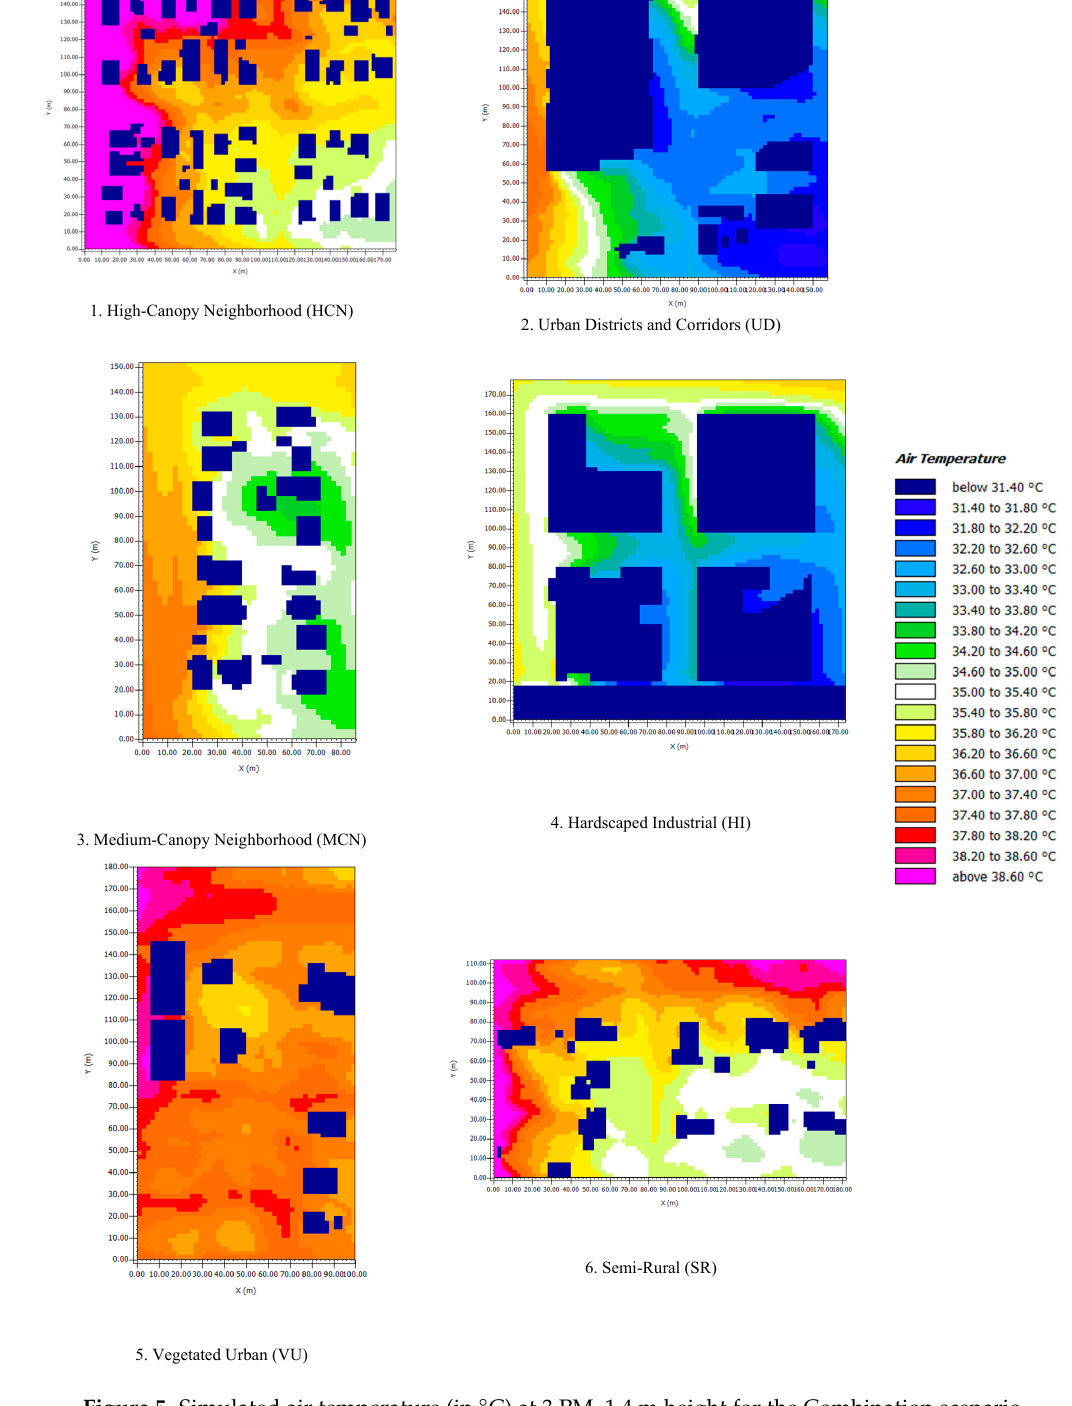
Figure 5. Simulated air temperature (in °C) at 3 PM, 1.4 m height for the Combination scenario. ◦ ◦ The NoGreen scenario increased temperature significantly for HCN ( + 6.9 C) and VU ( + 6.6 C), but ◦ ◦ ◦ ◦ had a lesser impact for SR ( + 3.9 C), MCN ( + 3.4 C), UD ( + 1.6 C) and HI ( + 0.5 C). The most significant increases were in land use categories that already had a lot of vegetation, and the least increase were in those locations with least. These results may suggest the importance of tree preservation programs, which we will discuss further in the Discussion section